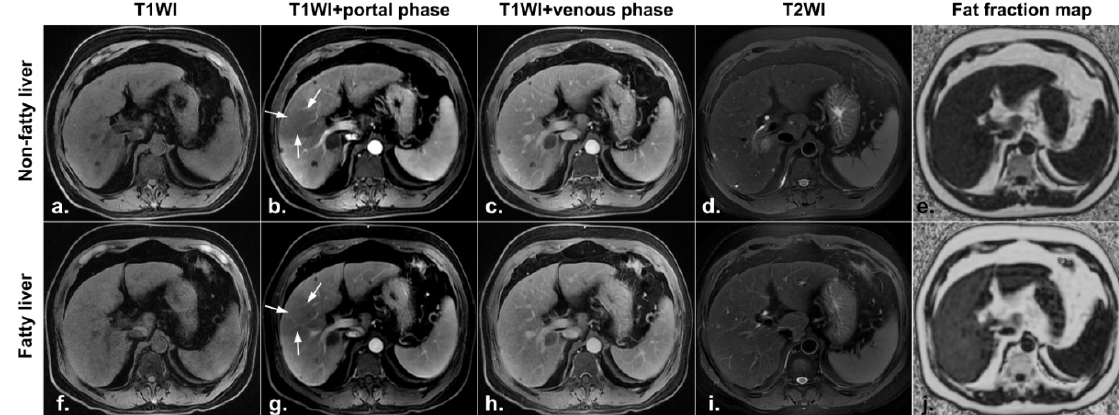
Figure 5. A 46-year-old male patient underwent interventional ablation of a small hepatocellular carcinoma. MRI images one month after radiofrequency ablation ( a – e ): no lesions were found on both T1W ( a , f ) and T2W ( d , i ); the fat fraction map showing no fat deposition in the liver ( e ); a contrast-enhanced image in the arterial phase showing hypoperfused foci(white arrows) in the liver ( b ); isointense signals in the portal venous phase ( c ). MRI images four months after radiofrequency ablation ( f – j ): a fat fraction map showing new fat deposition in the liver ( j ); a contrast-enhanced image in the arterial phase showing no obvious change in hypoperfused foci (white arrows) ( g ).